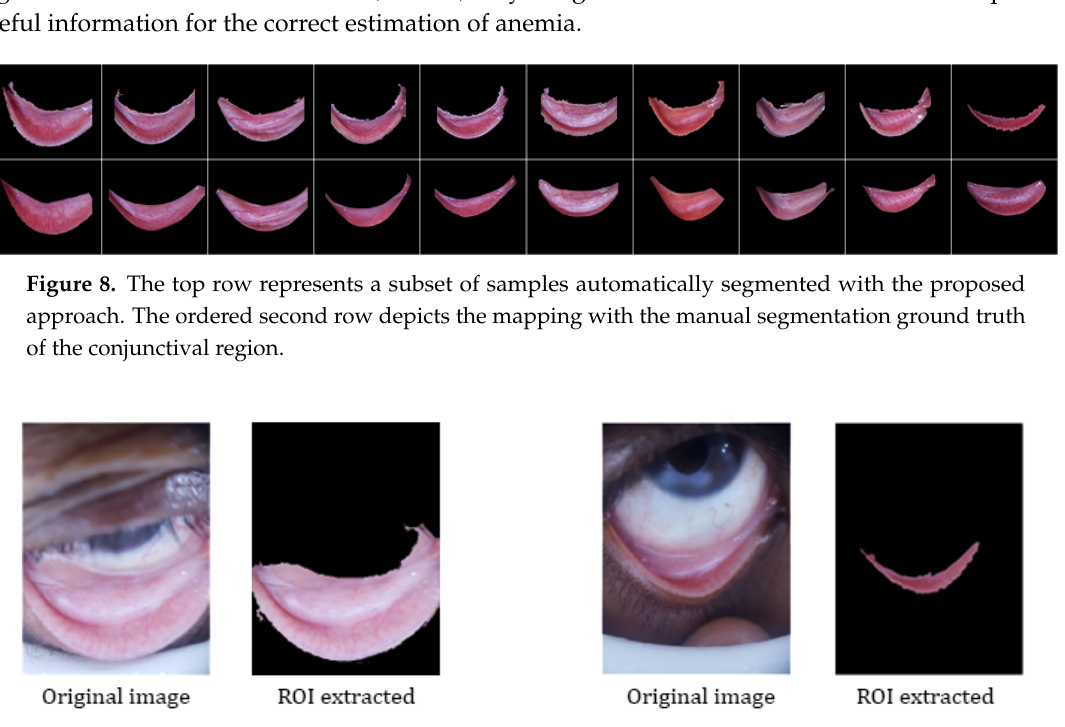
Figure 9. Examples of two images that would normally be discarded: the first because the eyelid overlaps the edge of the white spacer and is not perfectly in focus; additionally, the second one is not in focus and the finger appears to lower the eyelid. In both cases, automatic segmentation would still provide an acceptable